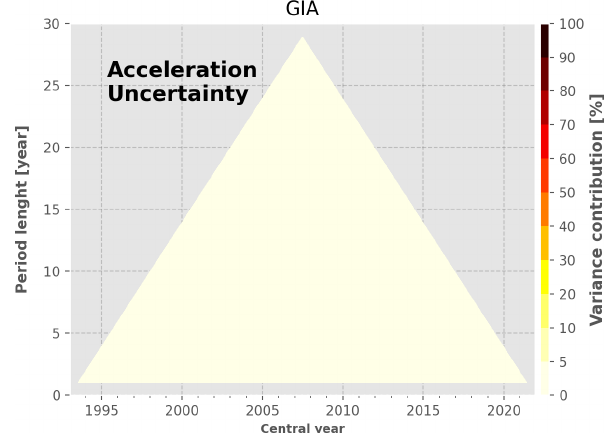
Figure B8. Variance contribution to the GMSL acceleration vari- ance of the GIA drift